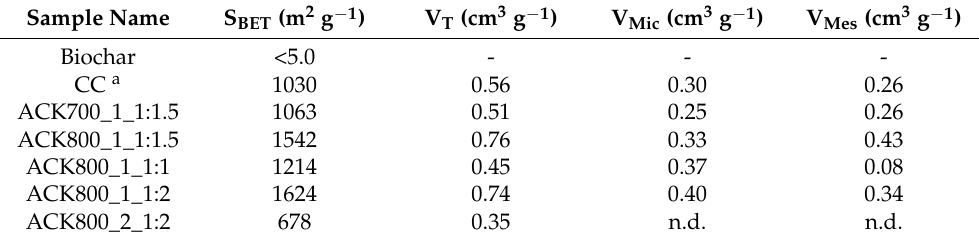
Table 2. Textural parameters of carbons obtained from the N 2 adsorption–desorption